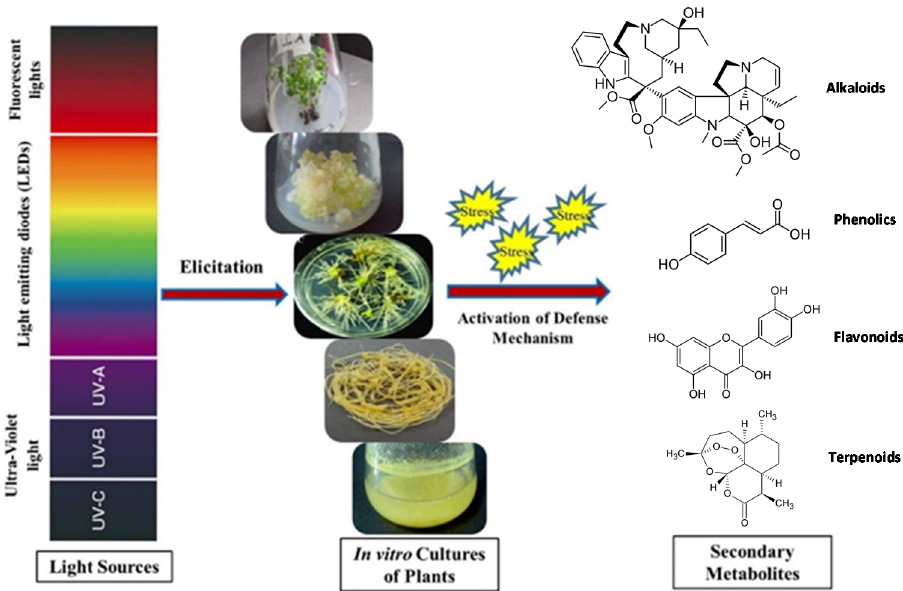
Figure 1. An overview of light’s function as an elicitor of important secondary metabolites in various in vitro plant cultures maintained under controlled conditions, including shoot, callus hairy